Question: Write a descriptive caption for this figure.
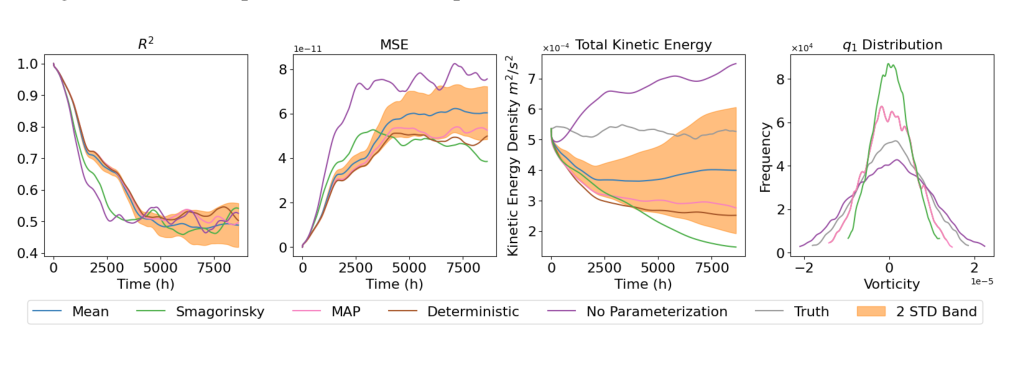
Answer: Metrics evaluating the performance of online predictions over 1 year period.